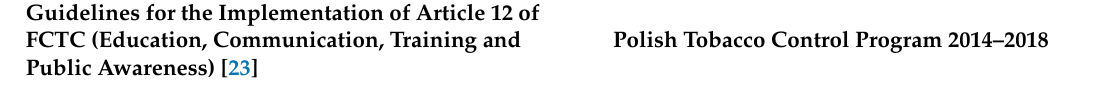
Table 2. Analysis of implementation of the Guidelines for The Implementation of Article 12 Of the WHO Framework Convention on Tobacco Control (Education, Communication, Training and Public Awareness) in a Polish Tobacco Control Program for years